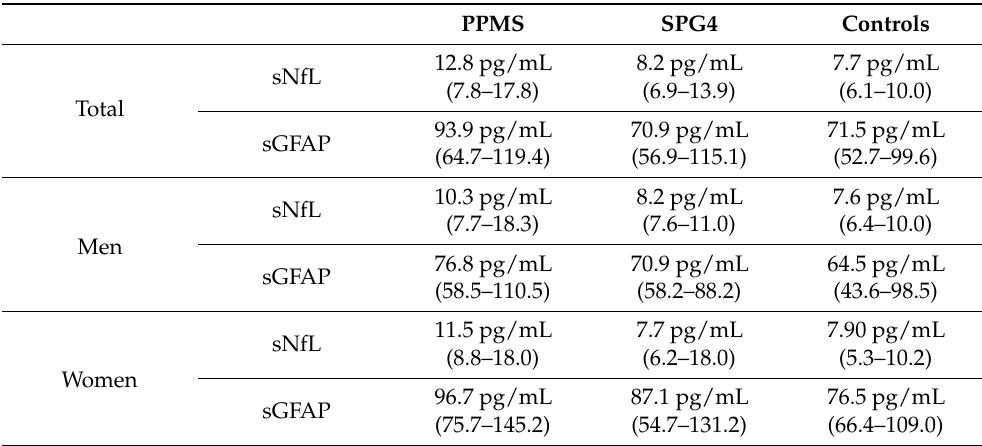
Figure 6. Ratio of serum NfL and serum GFAP levels in matched pairs of PPMS and SPG4 patients by mean age, with linear fit. Shaded areas represent 95% confidence intervals. In regard to sex, median sGFAP levels were higher in females than in males in all groups (Table 2). However, this difference did not reach significance in any group (Mann- Whitney test, PPMS: p = 0.103, SPG4: p = 0.744, controls: p = 0.100). Levels of sNfL did also not significantly vary between males and females (Mann-Whitney test, PPMS: p = 0.624, SPG4: p = 0.744, controls: p = 0.625), with relative differences being smaller for sNfL than for sGFAP. Table 2. Levels of sNfL and sGFAP in PPMS, SPG4 and controls.